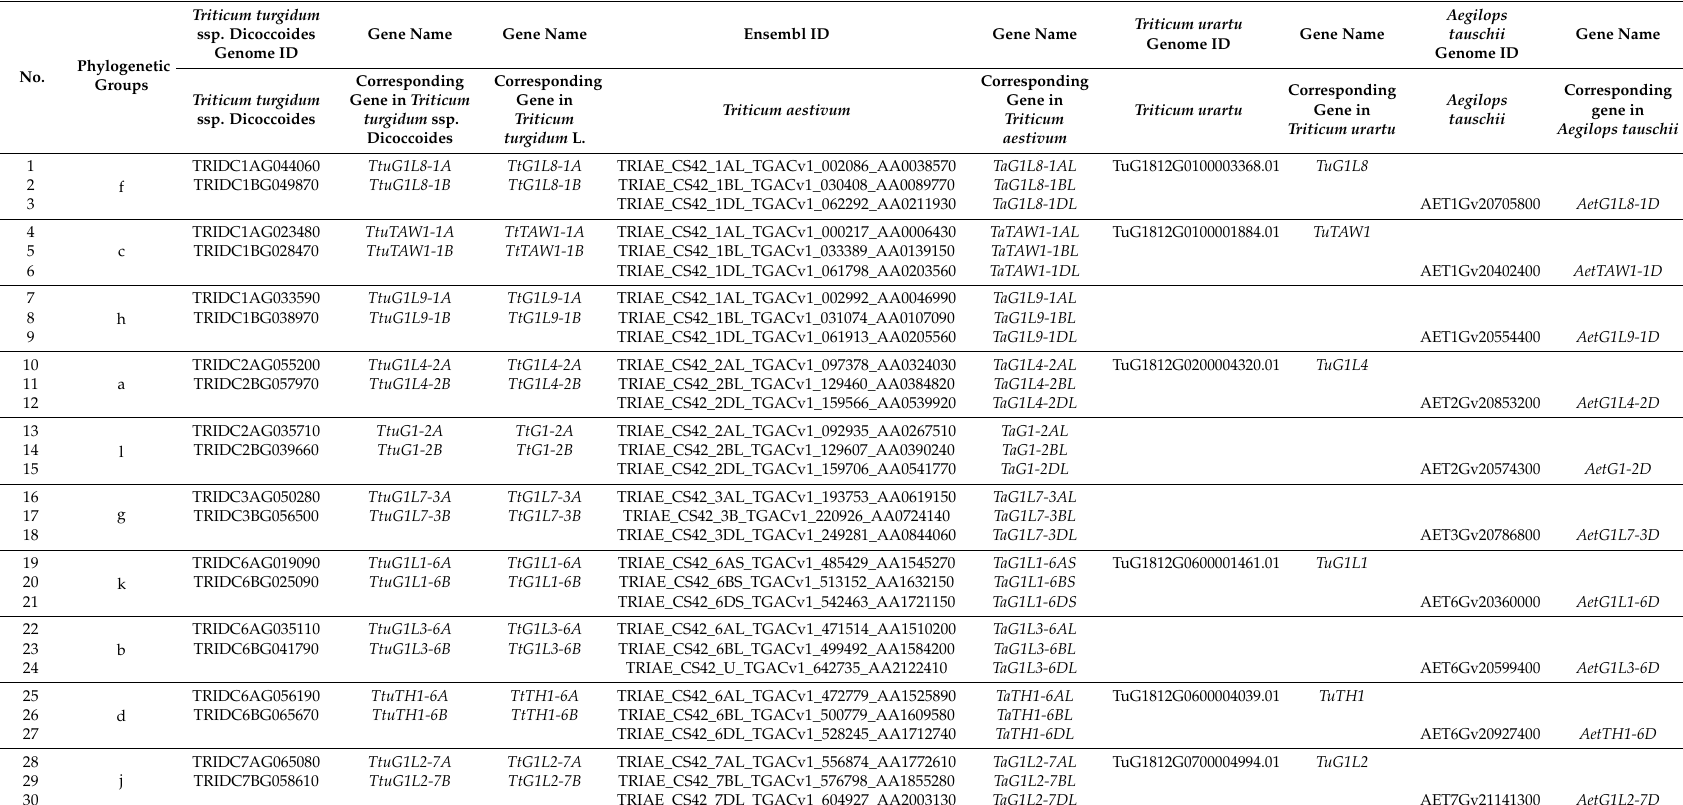
Table 2. Homologous copies of the wheat Arabidopsis LSH1 and Oryza G1 (ALOG)